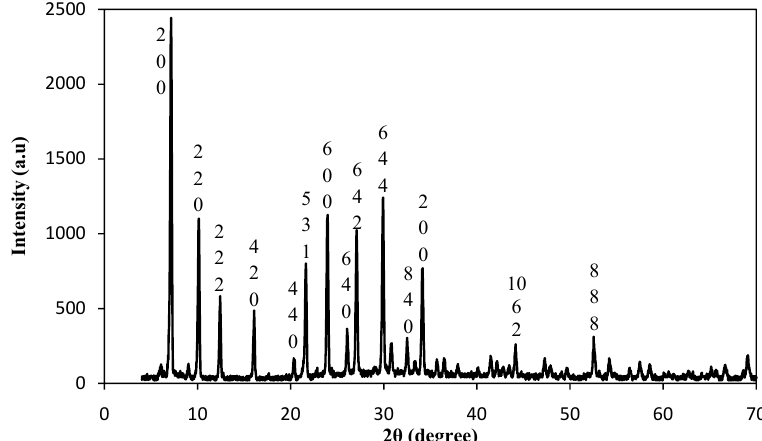
Fig. 6: XRD patterns of samples synthesized at 98 o C and 72 Fig. 6. XRD patterns of samples synthesized at 98 o C and 72 h.